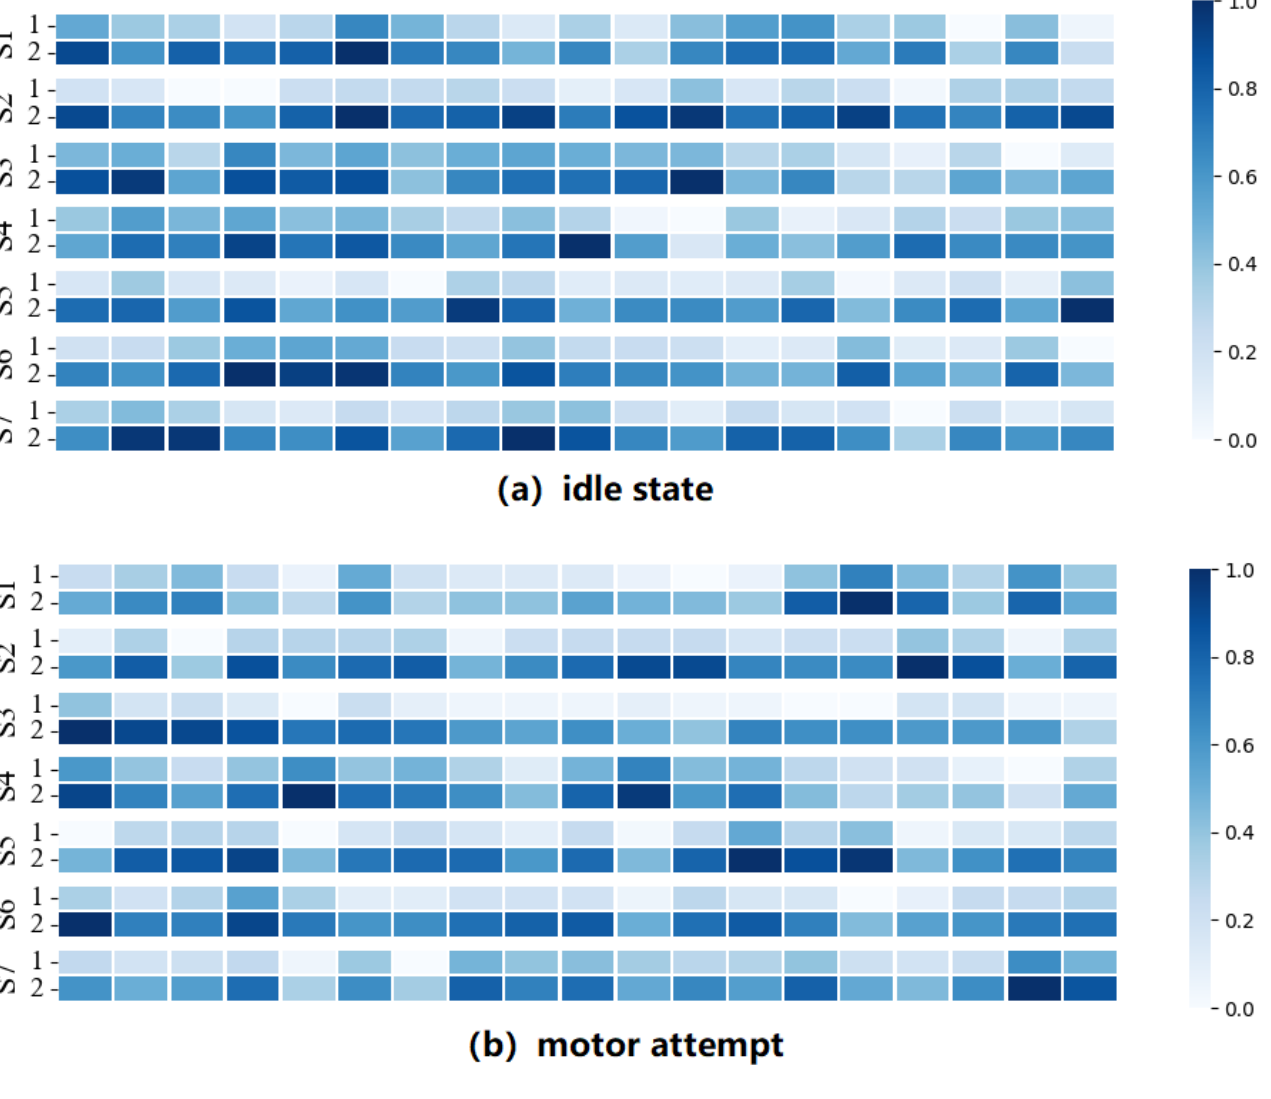
Figure 9. Visualization of classification results learned by LSTM&VS. In each state, two different sessions (1, 2) of seven subjects are visualized. Each row represents a session and each square represents the correct result for classification in a time